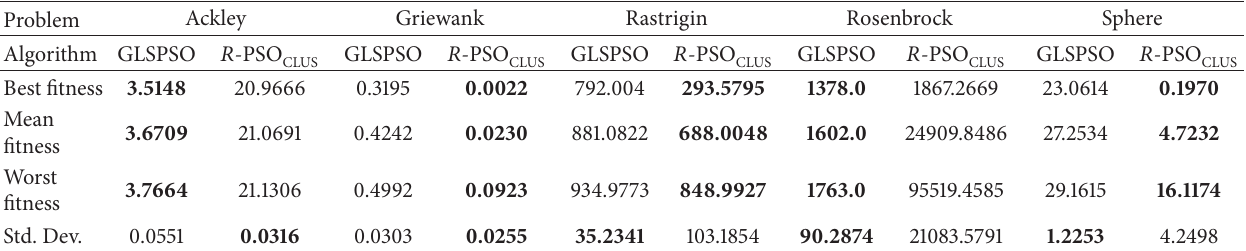
for problems with dimension of 100. CLUS